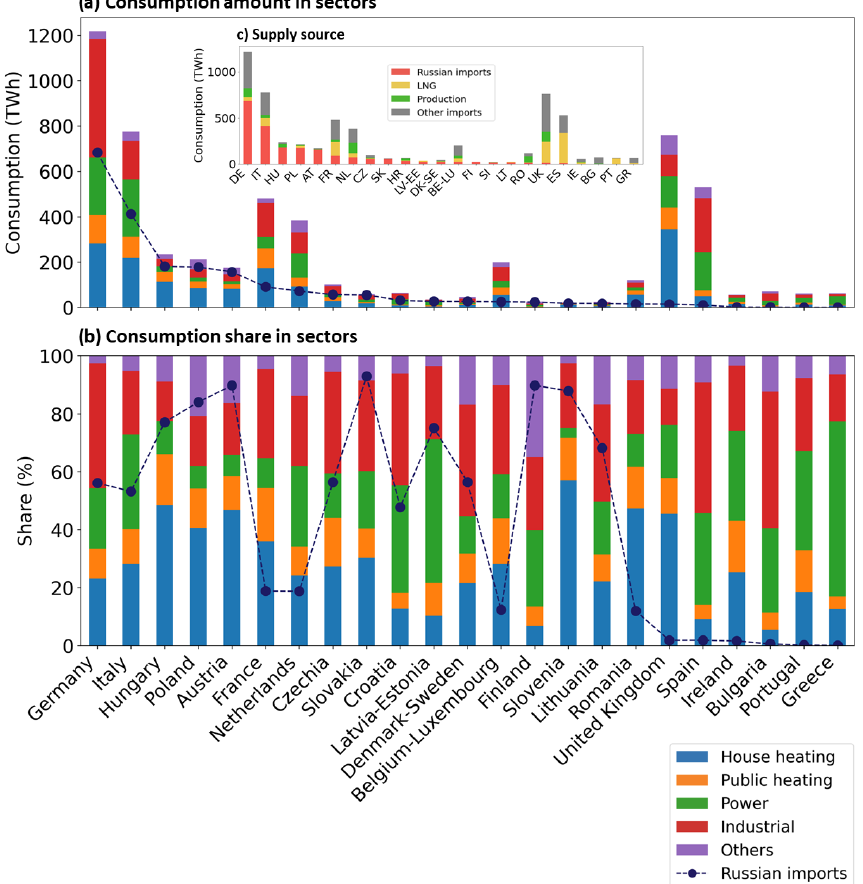
Figure 4. Gas supply and sectoral consumptions in each country for 2021. The figure panels show the country-based data for (a) the sectoral consumption amount including the Russian supply amount, (b) the sectoral consumption including the Russian supply share, and (c) the supply source amount (the inset plot). The countries are sorted by the amount of Russian